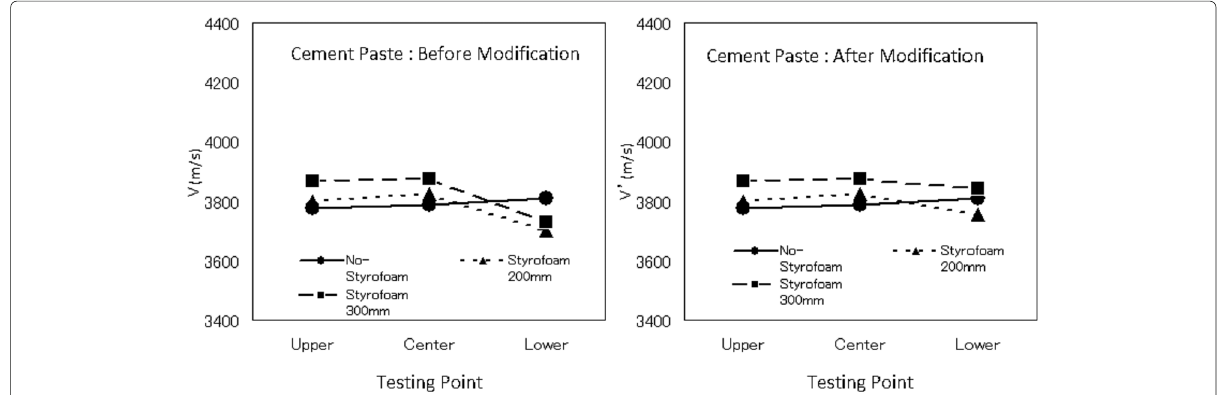
Fig. 6 Test pieces of cement paste with styrofoam (age of 4